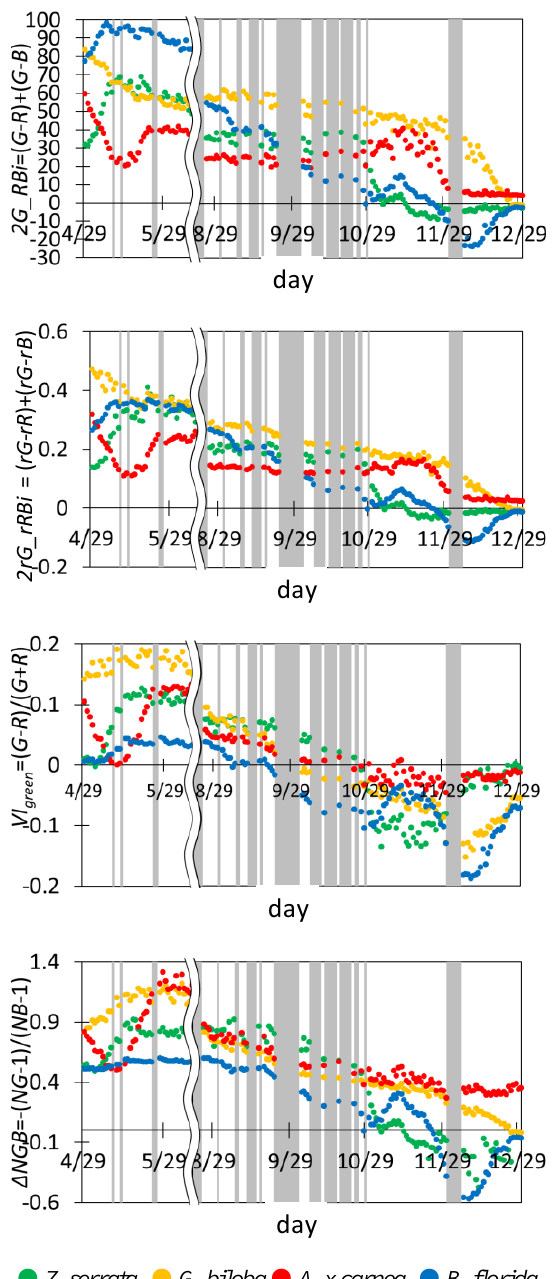
Figure 5. The seasonal fluctuation of each image index for 4 trees during from 29 th April to 31 st December. Since there was no big change from June to August, it is omitted in this